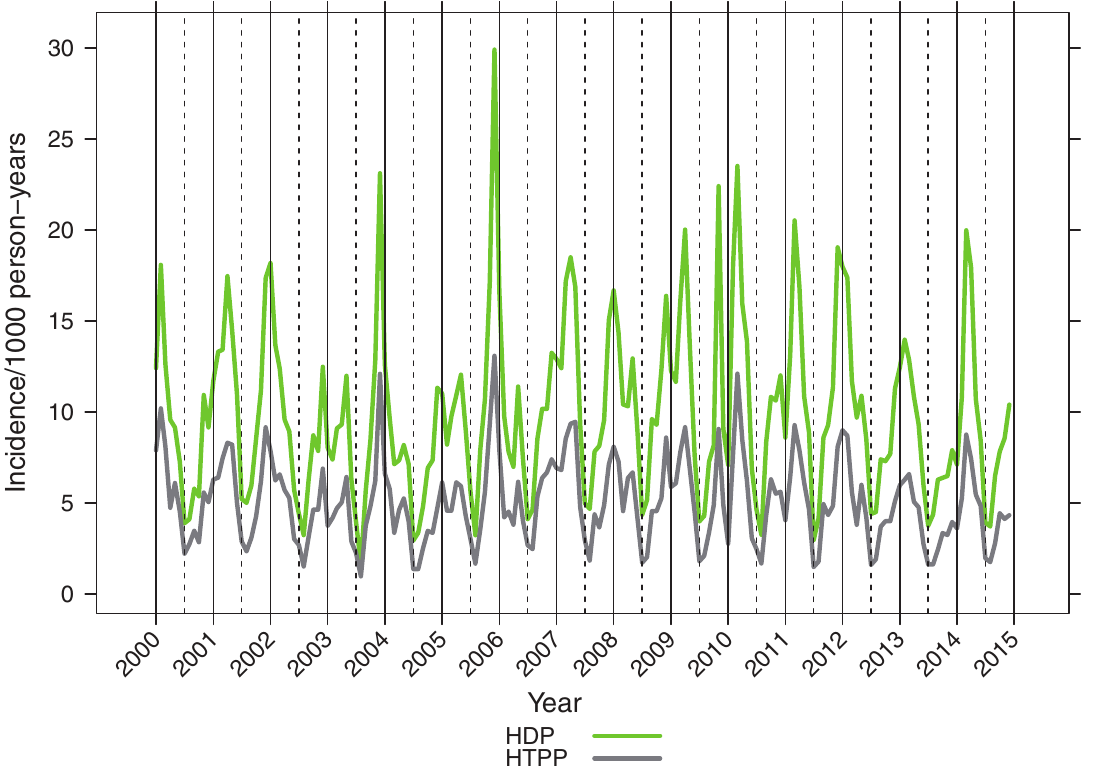
Fig 3. Monthly incidence rates of pneumonia in children < 24 months of age from 2000through end 2014 with vertical lines showing calendar yearsand dashed vertical lines showing epidemiological